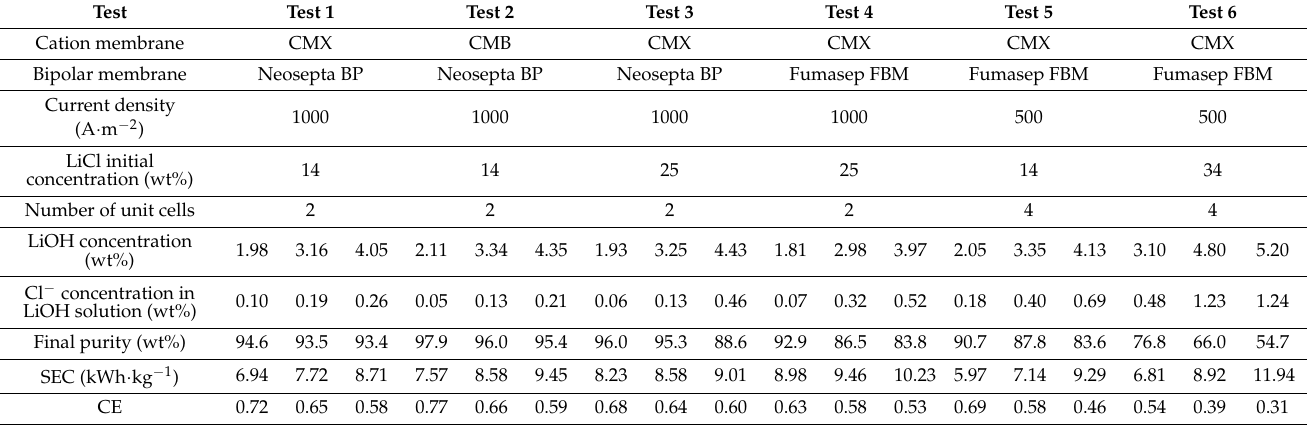
Table 8. Summary of the main results obtained in long-running